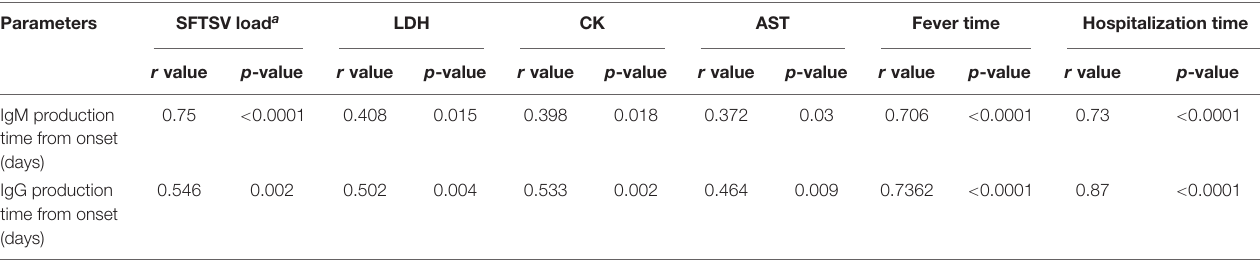
TABLE 1 | Correlation matrix of IgM and production time with parameters about condition of patients with severe fever with thrombocytopenia syndrome. Parameters